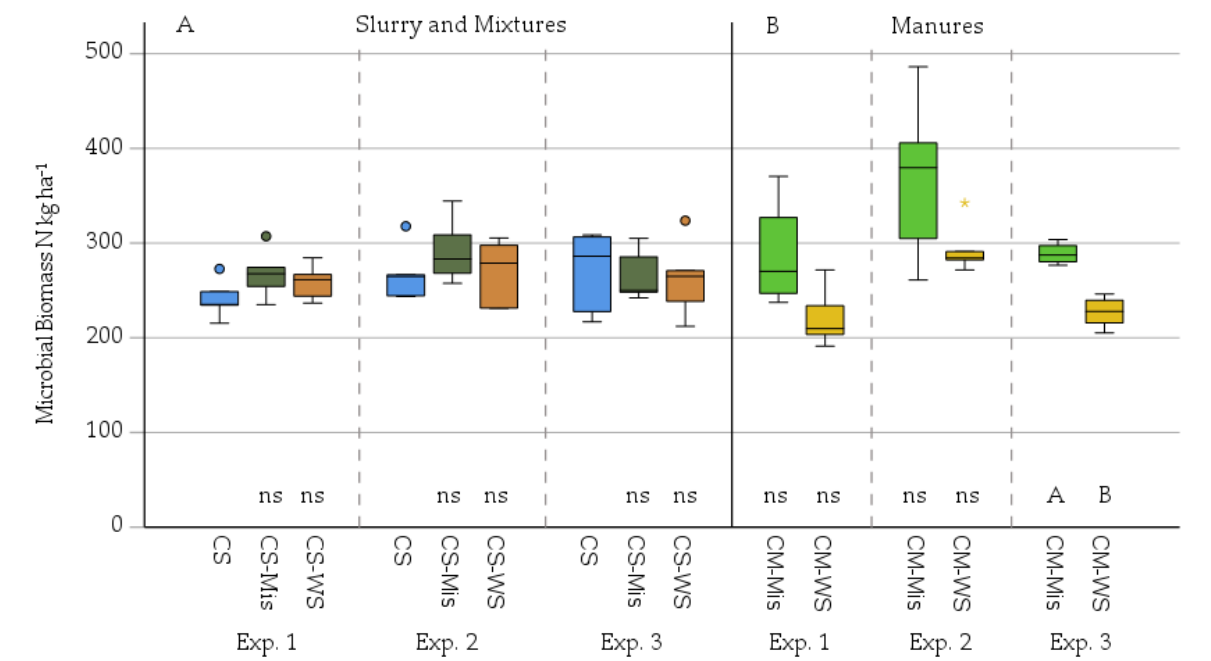
Figure 4. Microbial biomass N kg ha −1 of the soils, applied with different organic fertiliser for experiment 1 (120 kg total N ha − 1 ) and exp. 2 and 3 (170 kg total N ha − 1 ) at the end of the experiment for each treatment ( A ): CS = Cattle Slurry, CS- Mis = Cattle Slurry- Miscanthus (5 kg to 1 kg), CS-WS = Cattle Slurry-Wheat Straw (8.5 kg to 1 kg), ( B ): CM- Mis = Cattle Manure from Miscanthus shredded bedding, CM-WS = Cattle Manure from Wheat Straw shredded bedding). The dot indicates a “statistical outlier”; the star indicates an “extreme statistical outlier”. Different letters within a column and within each experiment number show significant differences between the two types of mixtures and between the two types of manure ( p < 0.05, t-test); ns = not significant; n = 5. Table 9. N immobilisation calculated of MBN of fertilised treatments and non-fertilised treatment (CS = Cattle Slurry, CS- Mis = Cattle Slurry- Miscanthus (5 kg to 1 kg), CS-WS = Cattle Slurry-Wheat Straw (8.5 kg to 1 kg), CM- Mis = Cattle Manure from Miscanthus shredded bedding, CM-WS = Cattle Manure from Wheat Straw shredded bedding, UAN = Urea Ammonium Nitrate).